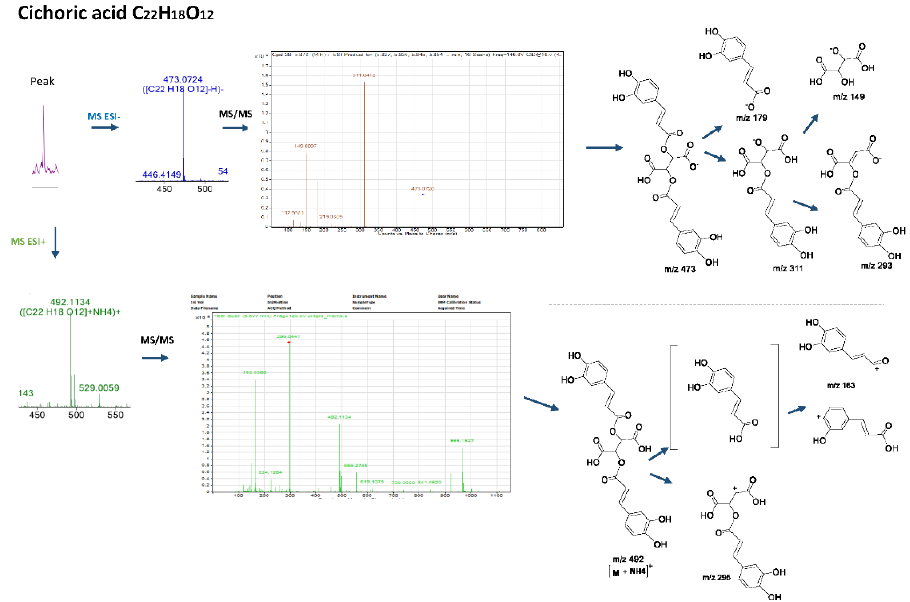
Figure 2. Mass spectra, fragmentation patterns and suggested molecular structures of diagnostic ions in positive and negative ion modes for cichoric acid.